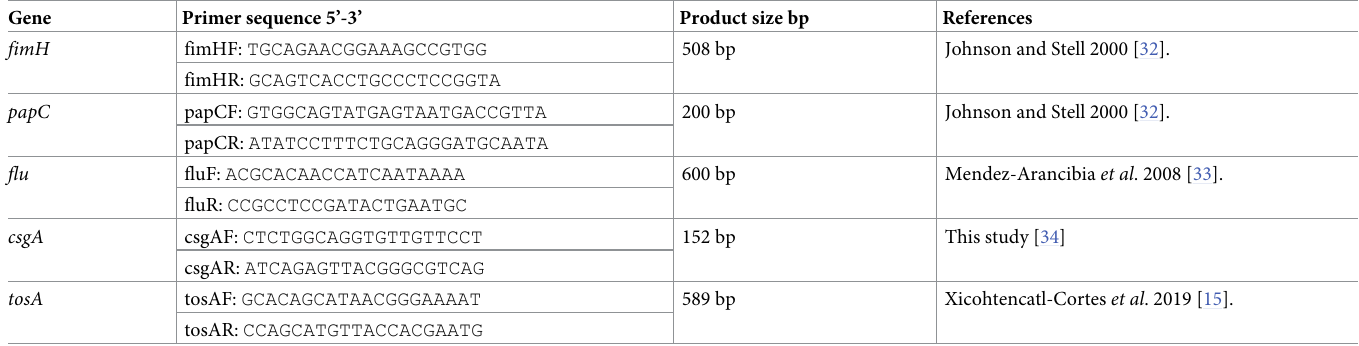
Table 1. List of primers used to adhesins genes